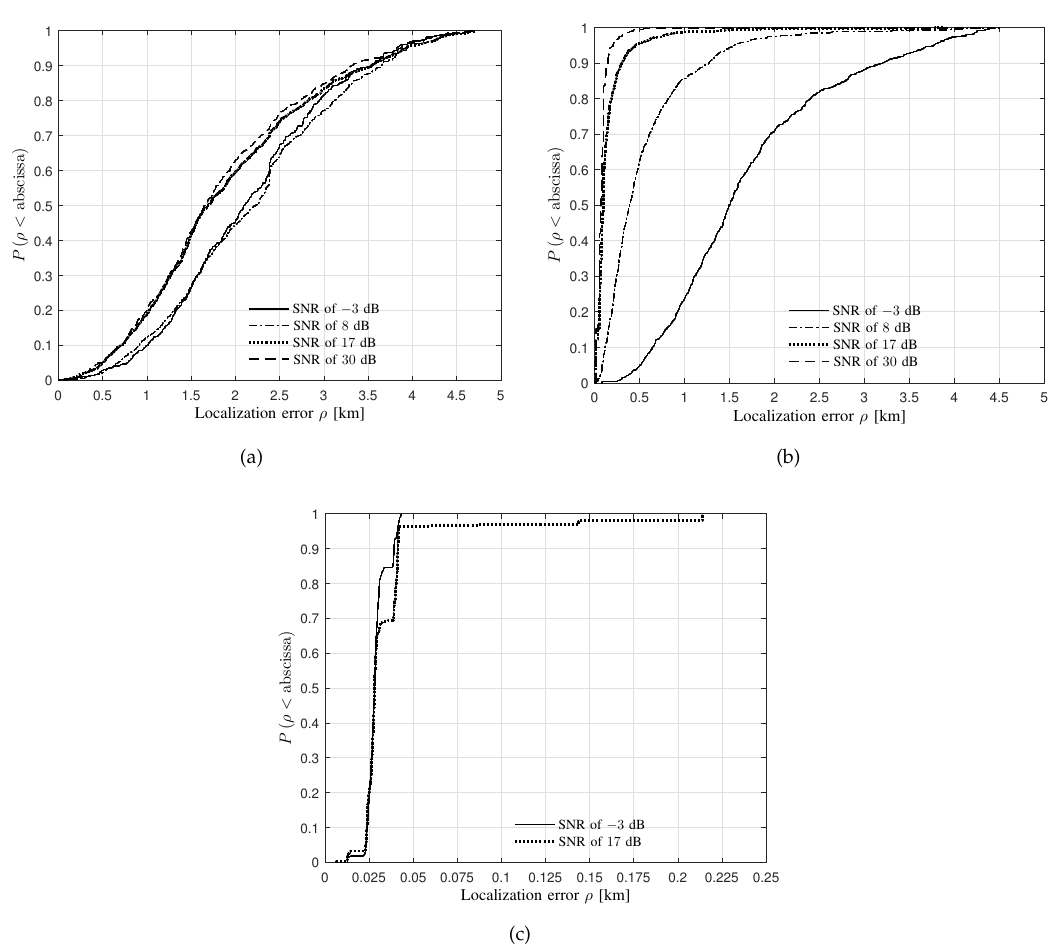
Figure 9. The Cumulative Distribution Functions (CDFs) of localization error for the LoS scenario obtained from the verification of the proposed performance-evaluation approach using the commercial localization system. ( a ) BW of 5 KHz; ( b ) BW of 25 KHz; ( c ) BW of 3125